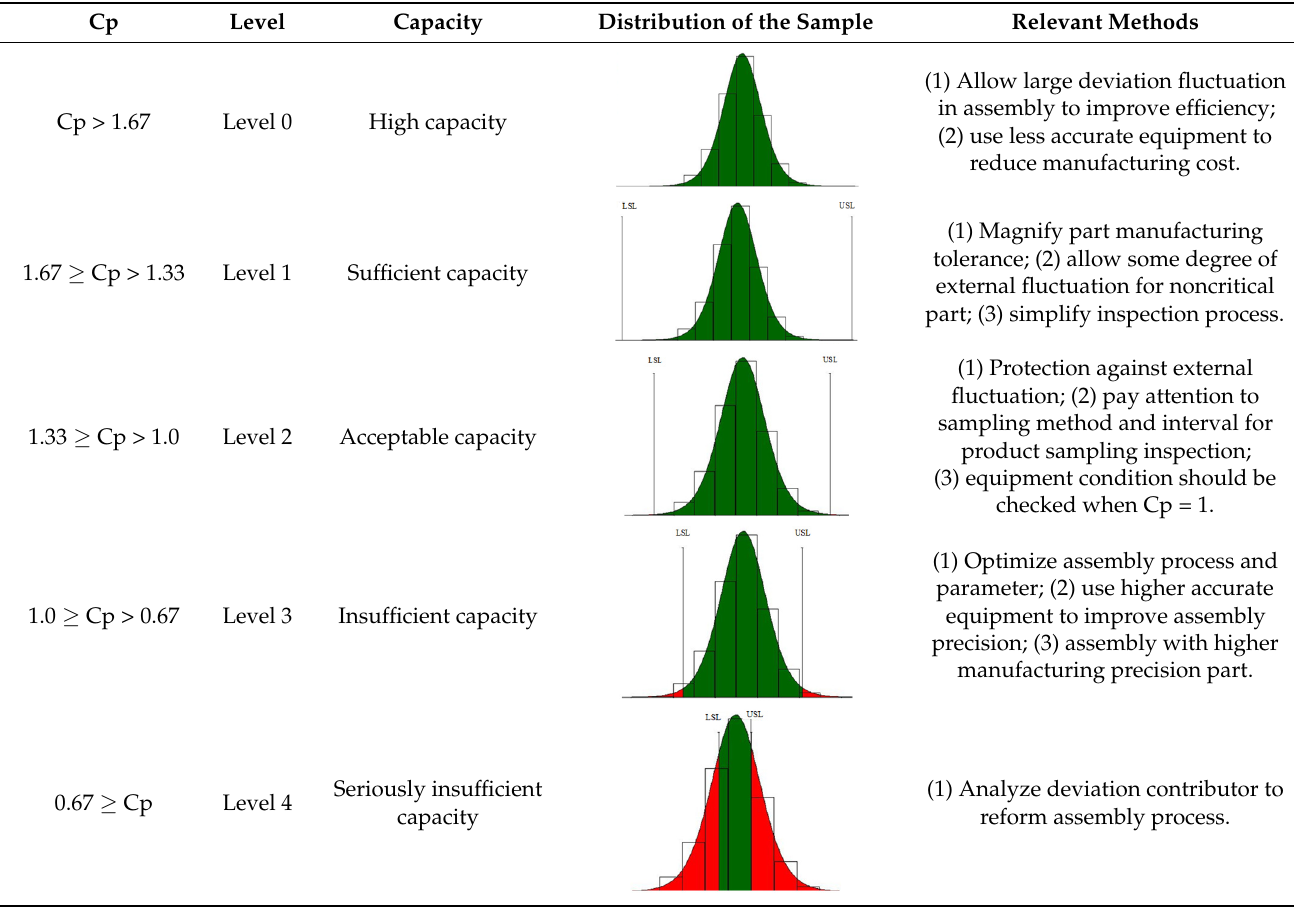
Table 3. Assembly process capacity level division based on Cp.